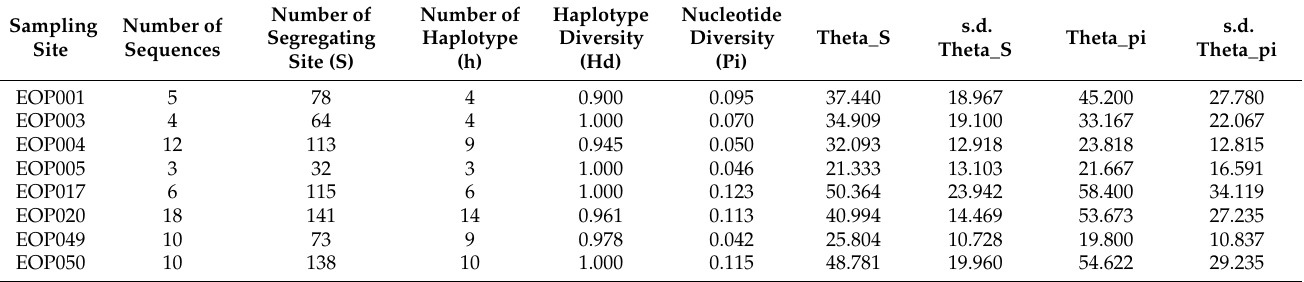
Table 4. Polypedilum genus genetic diversity from eight sampling sites in El Oro Province